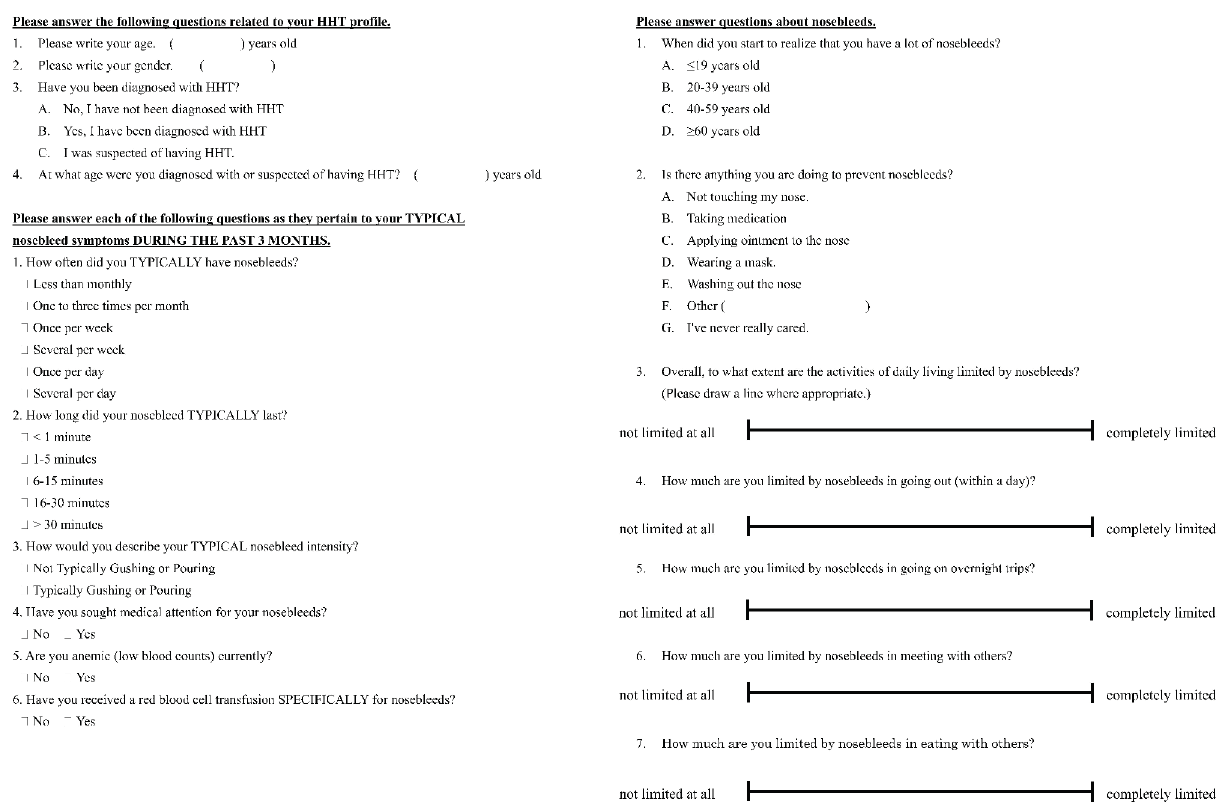
Figure 1. The questionnaire form regarding the ESS and the performed activities of daily living. This form was translated into English. The actual ques- tionnaire was written in Japanese. ESS, epistaxis severity